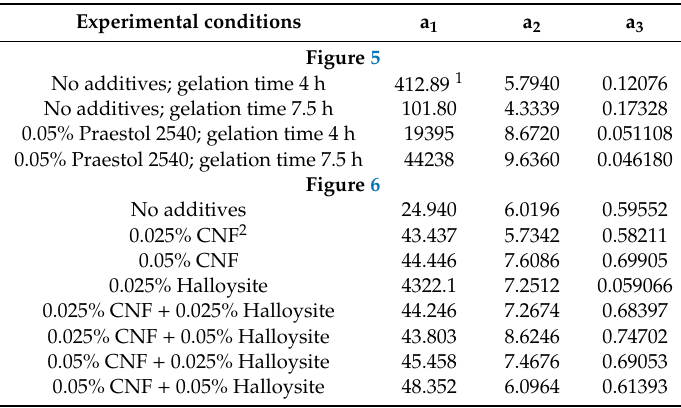
Figure A1 . Scheme of the Veiler–Rebinder apparatus for the measurements of gel strength. 1, Z-stage; 2, perforated carbon steel plate; 3, gel; 4, vessel; 5, analytical balance. Table A1. The fitted parameters for Equation (1).